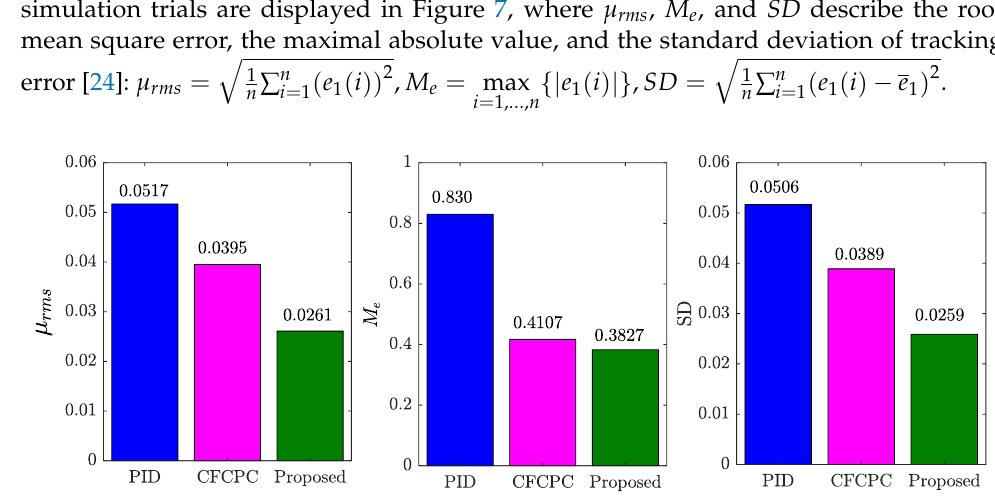
Figure 7. Histogram of performance indexes.